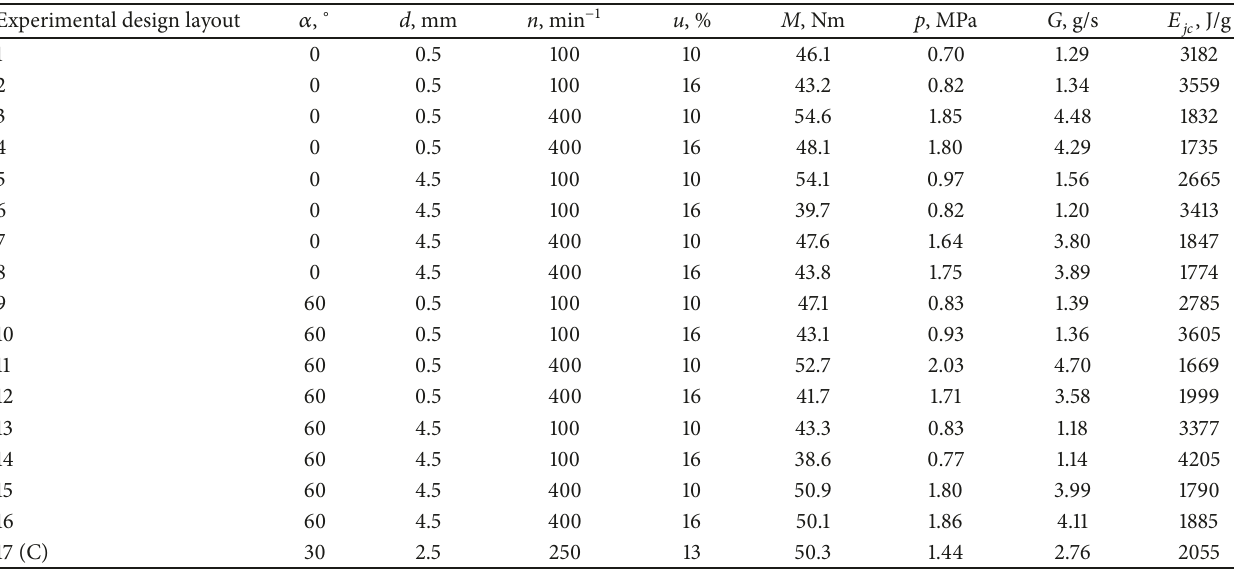
Figure 3: Schematic design of (a) tested segment, (b) three-lobe kneading element, (c) angle between the kneading elements, and (d) width of the gap between the kneading elements. Table 1: Experimental